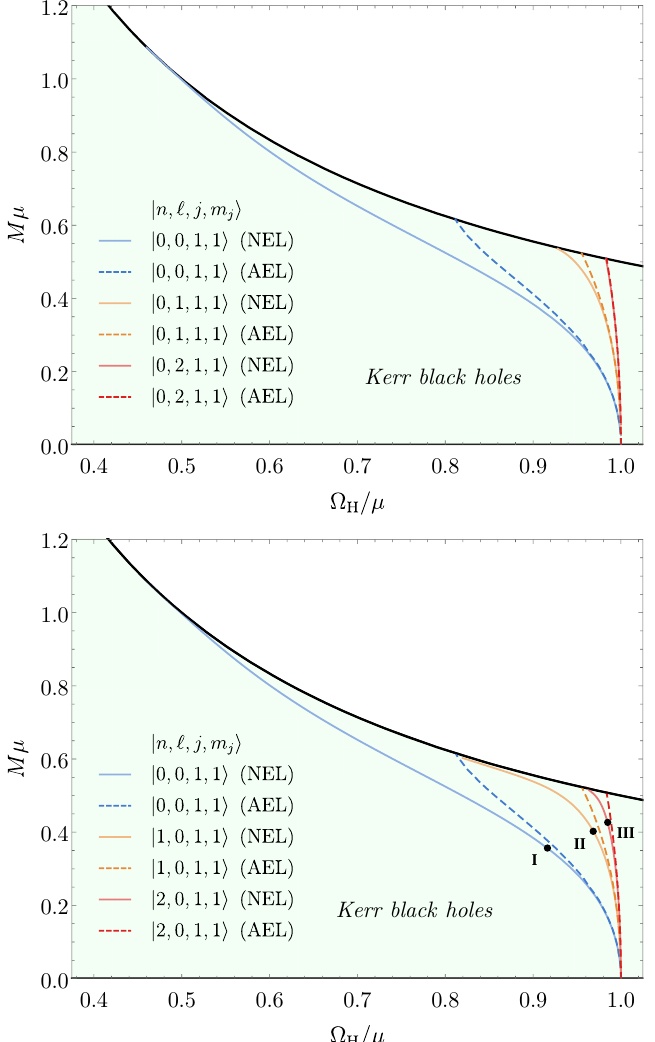
Figure 1 . Existence lines for the vector stationary clouds in the ( M; (cid:10) H )-plane. The black solid line refers to extremal ( a = M ) Kerr BHs. (Top panel) j 0 ; ‘; 1 ; 1 i with ‘ 2 f 0 ; 1 ; 2 g . The ‘ = 0 vector states are the least energetic, as they correspond to lower values of (cid:10) H . The energy increases with ‘ . (Bottom panel) j n; 0 ; 1 ; 1 i with n 2 f 0 ; 1 ; 2 g . The n = 0 vector states are the least energetic, as they correspond to lower values of (cid:10) H . The energy increases with n